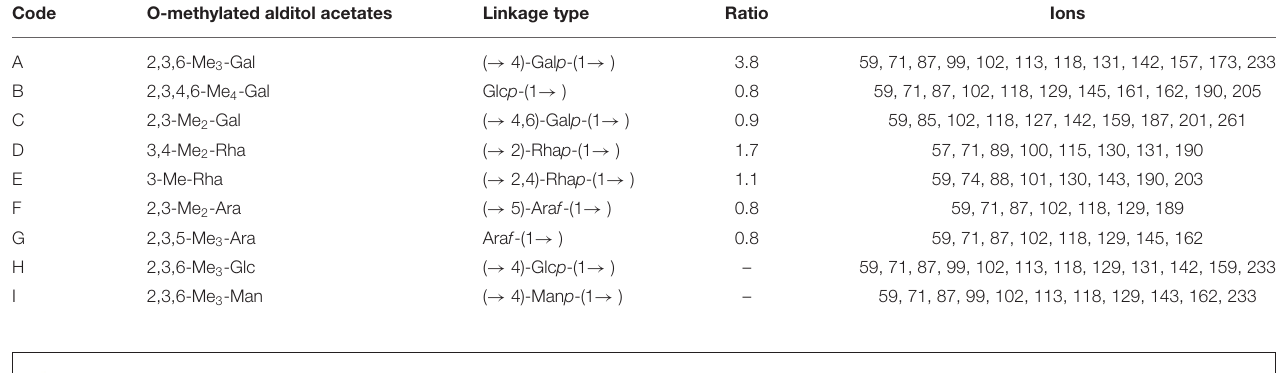
TABLE 1 | Methylation analysis results of RCHP-S after reduction.